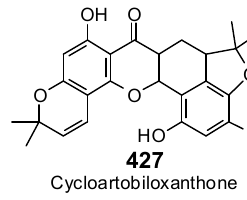
Figure 18. Phenylpropanoids and lignans examined in this work.